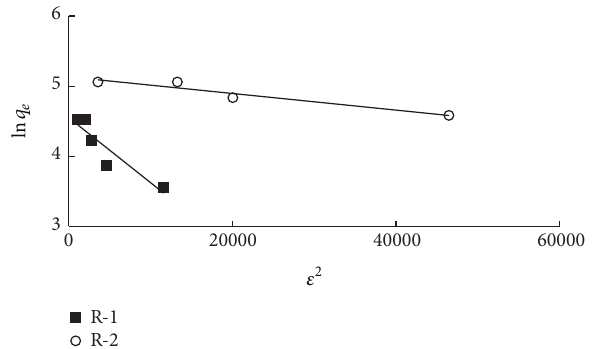
Figure 11: Dubinin-Radushkevich isotherm model.